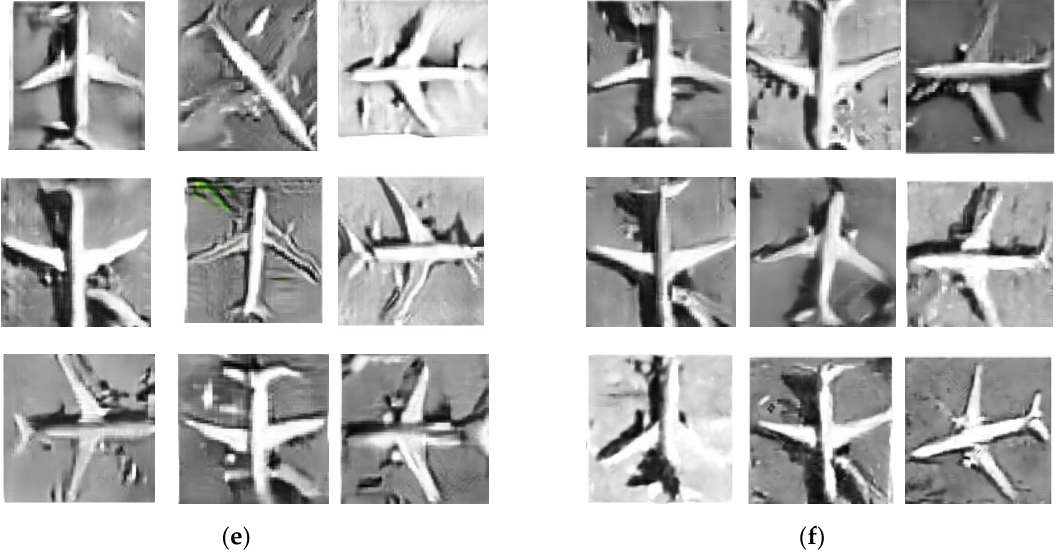
Figure 9. Samples of database and generated pictures of different GAN models. ( a ) Real images from the database; ( b ) generated pictures of GANs; ( c ) generated pictures of SAGAN; ( d ) generated pictures of CBAM-GAN; ( e ) generated pictures of coordinate attention GAN; ( f ) generated pictures of modified shuffle attention GAN.